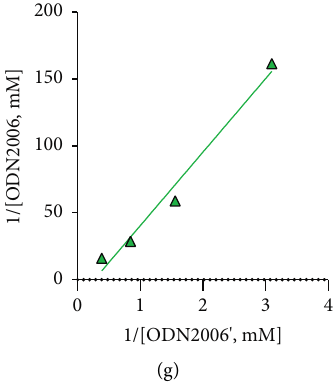
Figure 3: NPT1220-312 is an allosteric antagonist at TLR2 and TLR9. NPT1220-312 suppressed: (a) Pam 2 CSK 4 -, (b) Pam 3 CSK 4 -, and (c) ODN2006-evoked SEAP release (OD655nm) to the medium in hTLR2 HEK293 cells; (d) the dose-effect curve for an agonist determined in the presence of various concentrations of an antagonist, Schild plots; and (e–g) dose ratios derived from Gaddum analysis of EC 50 and IC 50 values for (e) Pam 2 CSK 4 , (f) Pam 3 CSK 4 , and (g) ODN2006. NPT1220-312 concentration dependently suppressed the maximum TLR2 or TLR9 agonist-evoked responses in a manner consistent with a non-competitive interaction [40].